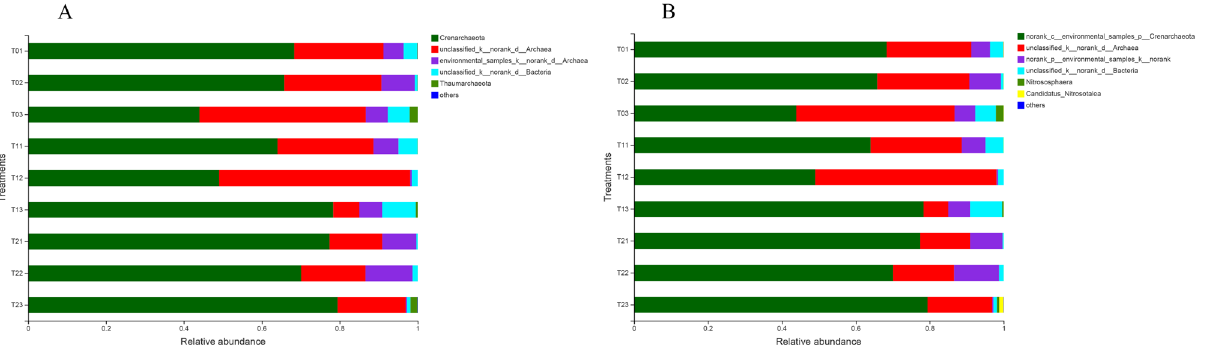
Figure 5. Relative abundance of ammonia-oxidizing archaea (AOA) phyla ( A ) and genera ( B ) under different fertilization and irrigation regimes. The relative abundance is expressed as the mean percentage of the targeted sequences to the total high-quality bacterial and fungal sequences of samples from triplicate plots of each irrigation and fertilization treatment. Notes : T 0 = Traditional irrigation; T 1 = Traditional irrigation and fertilization practice; T 2 = Water-saving irrigation and optimizing fertilization.